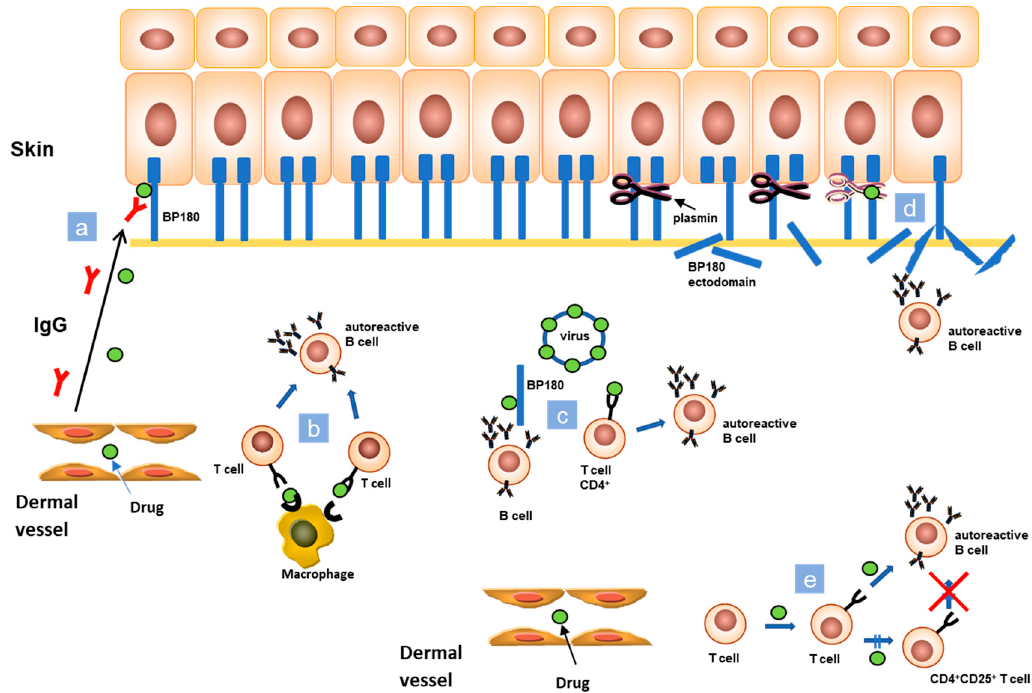
Figure 2. Schematic representation of proposed mechanisms of drug induced BP. ( a ) Drugs can act as antigens, involving endogenous proteins in covalent binding. They could modify their antigenic properties exposing hidden antigenic sites or generating new antigens. ( b ) Low molecular weight drugs could become immunogenic through non-covalent binding with molecules, such as major histocompatibility complex class (MHC) and T-cell receptors (TCRs) causing an immune response. ( c ) Another suggested mechanism at the basis of BP induction is molecular mimicry. It is possible that medications are mistaken with microbial antigens. This could also lead to activation of CD4 + T-cells and initiation of the autoimmune cascade. ( d ) The inhibition of plasmin by dipeptidyl peptidase 4 inhibitors (DPP-4i) could provoke alterations in the correct cleavage of BP180, modifying its antigenicity. ( e ) Some drugs can also cause the inactivation of endogenous regulatory processes involving T-cells or force immune checkpoint of T-cells, such as for antibodies against the immune checkpoint PD-1 and